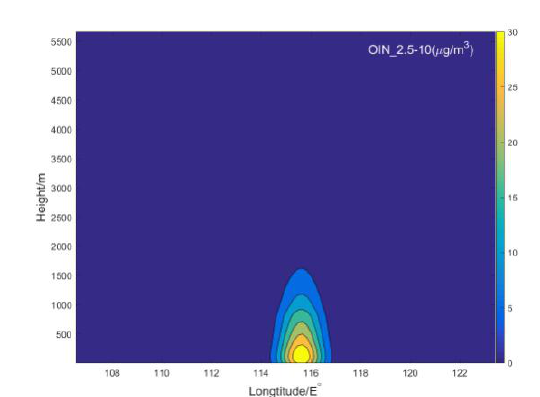
Figure 7 Mass concentrations distribution vertically of the No.16 control variable after data